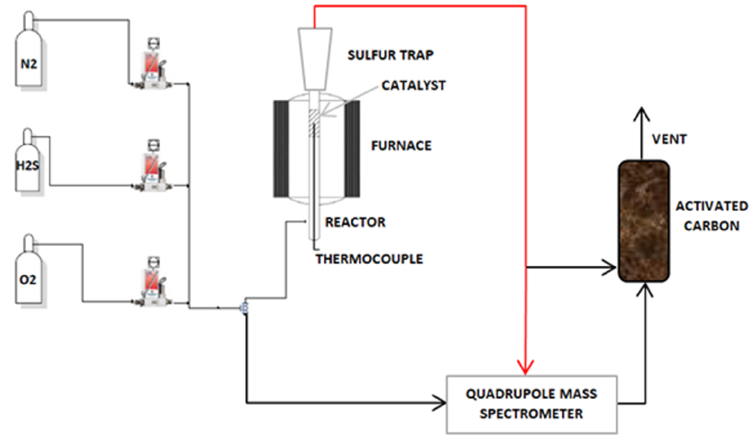
Figure 11. Scheme of the apparatus plant. All the lines downstream of the reactor were heated at the temperature of 170 ◦ C to avoid sulfur solidification and possible clogging of the mass spectrometer capillary and to maintain the water in the gas phase for the analysis. The analysis of the gaseous stream (H 2 S, O 2 , N 2 , SO 2 , SO 3 ) was performed with the mass spectrometer quadrupole (Hiden HPR-20) (Warrington, United Kingdom).